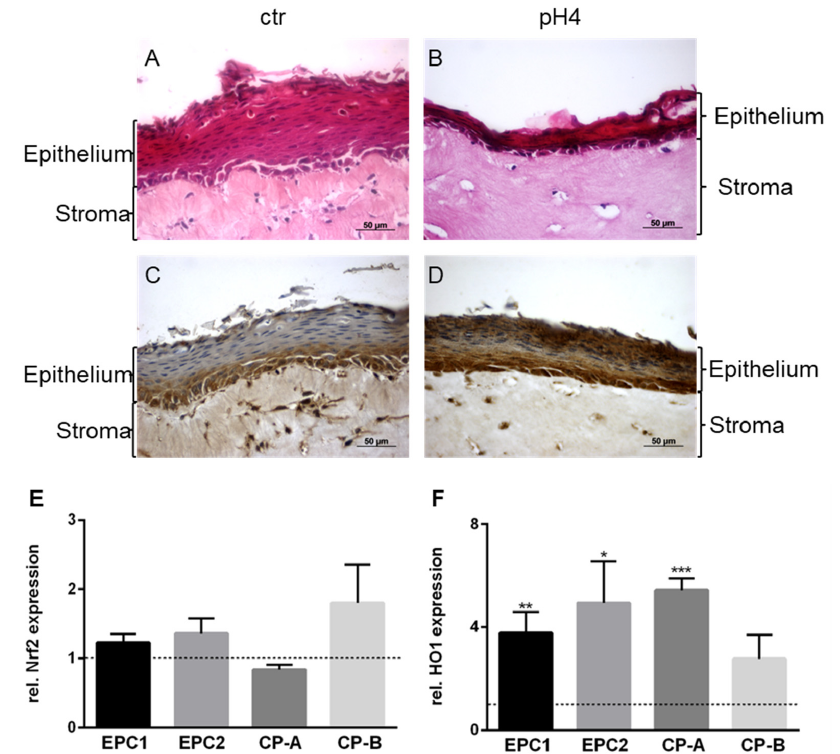
Figure 7. Histological and immunohistochemical staining of organotypic 3D-cultures and gene expression in non-malignant cells with chronical acid treatment. The squamous epithelial cell line (EPC2) was grown on top of a matrix-embedded fibroblasts (FEF3) layer in organotypic 3D-cultures and treated with acidic medium (pH 4) chronically for five consecutive days and three times a day for 1 min. Sections were stained with hematoxylin-eosin ( A , B ) and immunohistochemistry (DAB) was done for HO1 ( C , D ). The organotypic 3D-cultures are shown in 40 × magnification. Expression of Nrf2 ( E ) and HO1 ( F ) were assessed via quantitative RT-PCR. EPC1 and EPC2 (esophageal squamous epithelium), CP-A (Barrett’s metaplasia) and CP-B (Barrett’s high-grade dysplasia) were treated two days. Values are shown as mean ± S.E.M. (Student’s t-test was performed compared to the respective untreated control; ***— p < 0.001, **— p < 0.01, *— p <